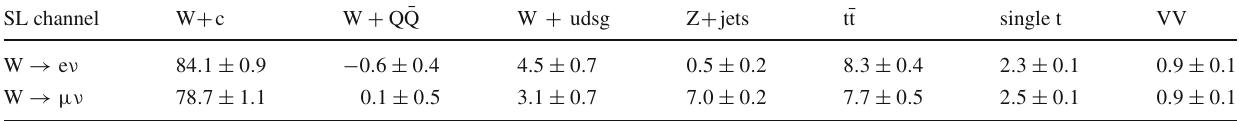
Table 2 Simulated flavour composition (in %) of the SL sample after the selection summarized in Table 1 and OS–SS subtraction, for the electron and muon decay channels of the W boson. W + Q ¯ Q is the sum